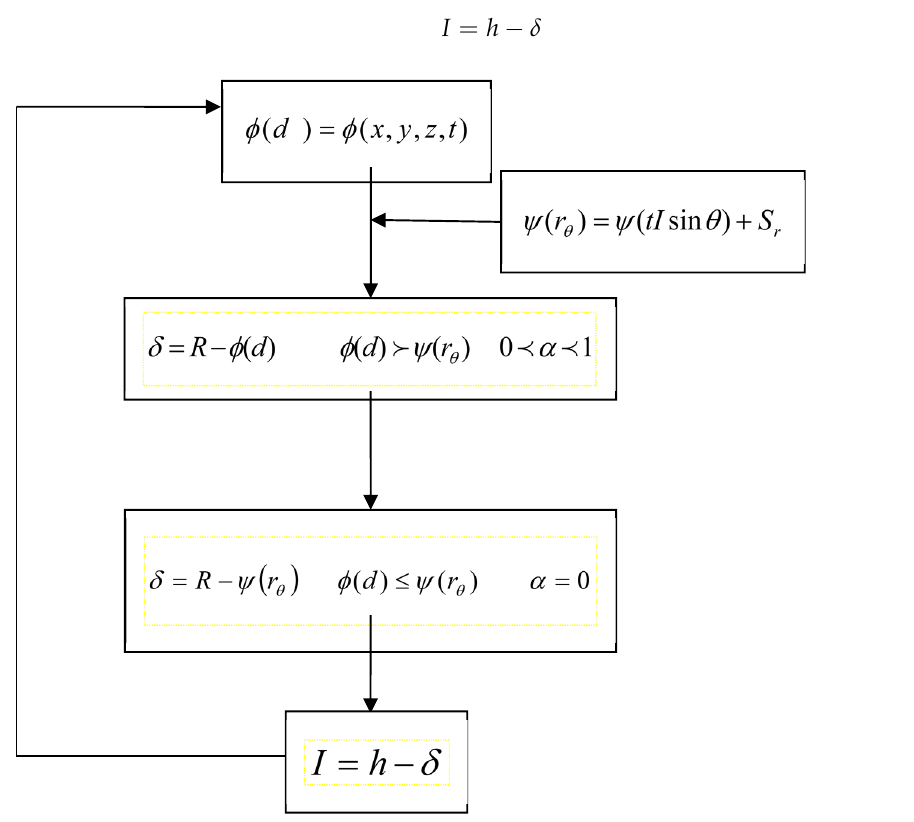
Figure 5. A general diagram of equations and UDF used in simulation.